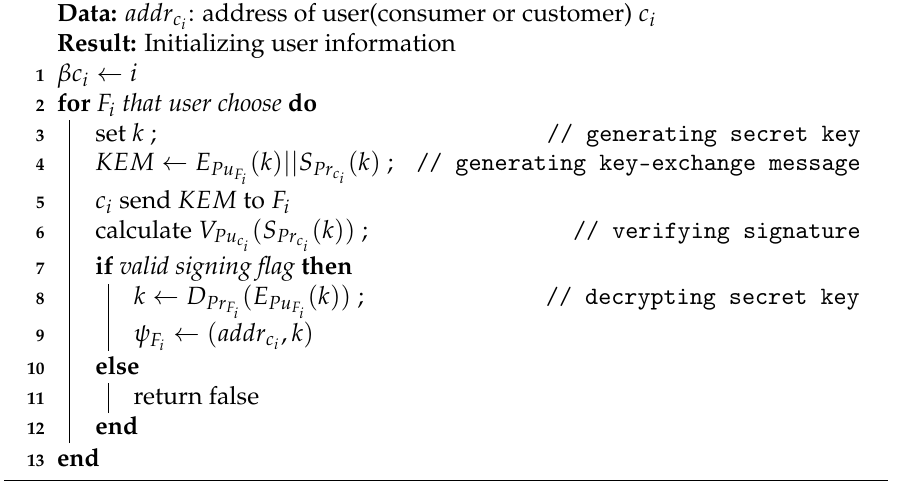
Algorithm 1 conducts initialization of user reliability and key exchange between users and feeds